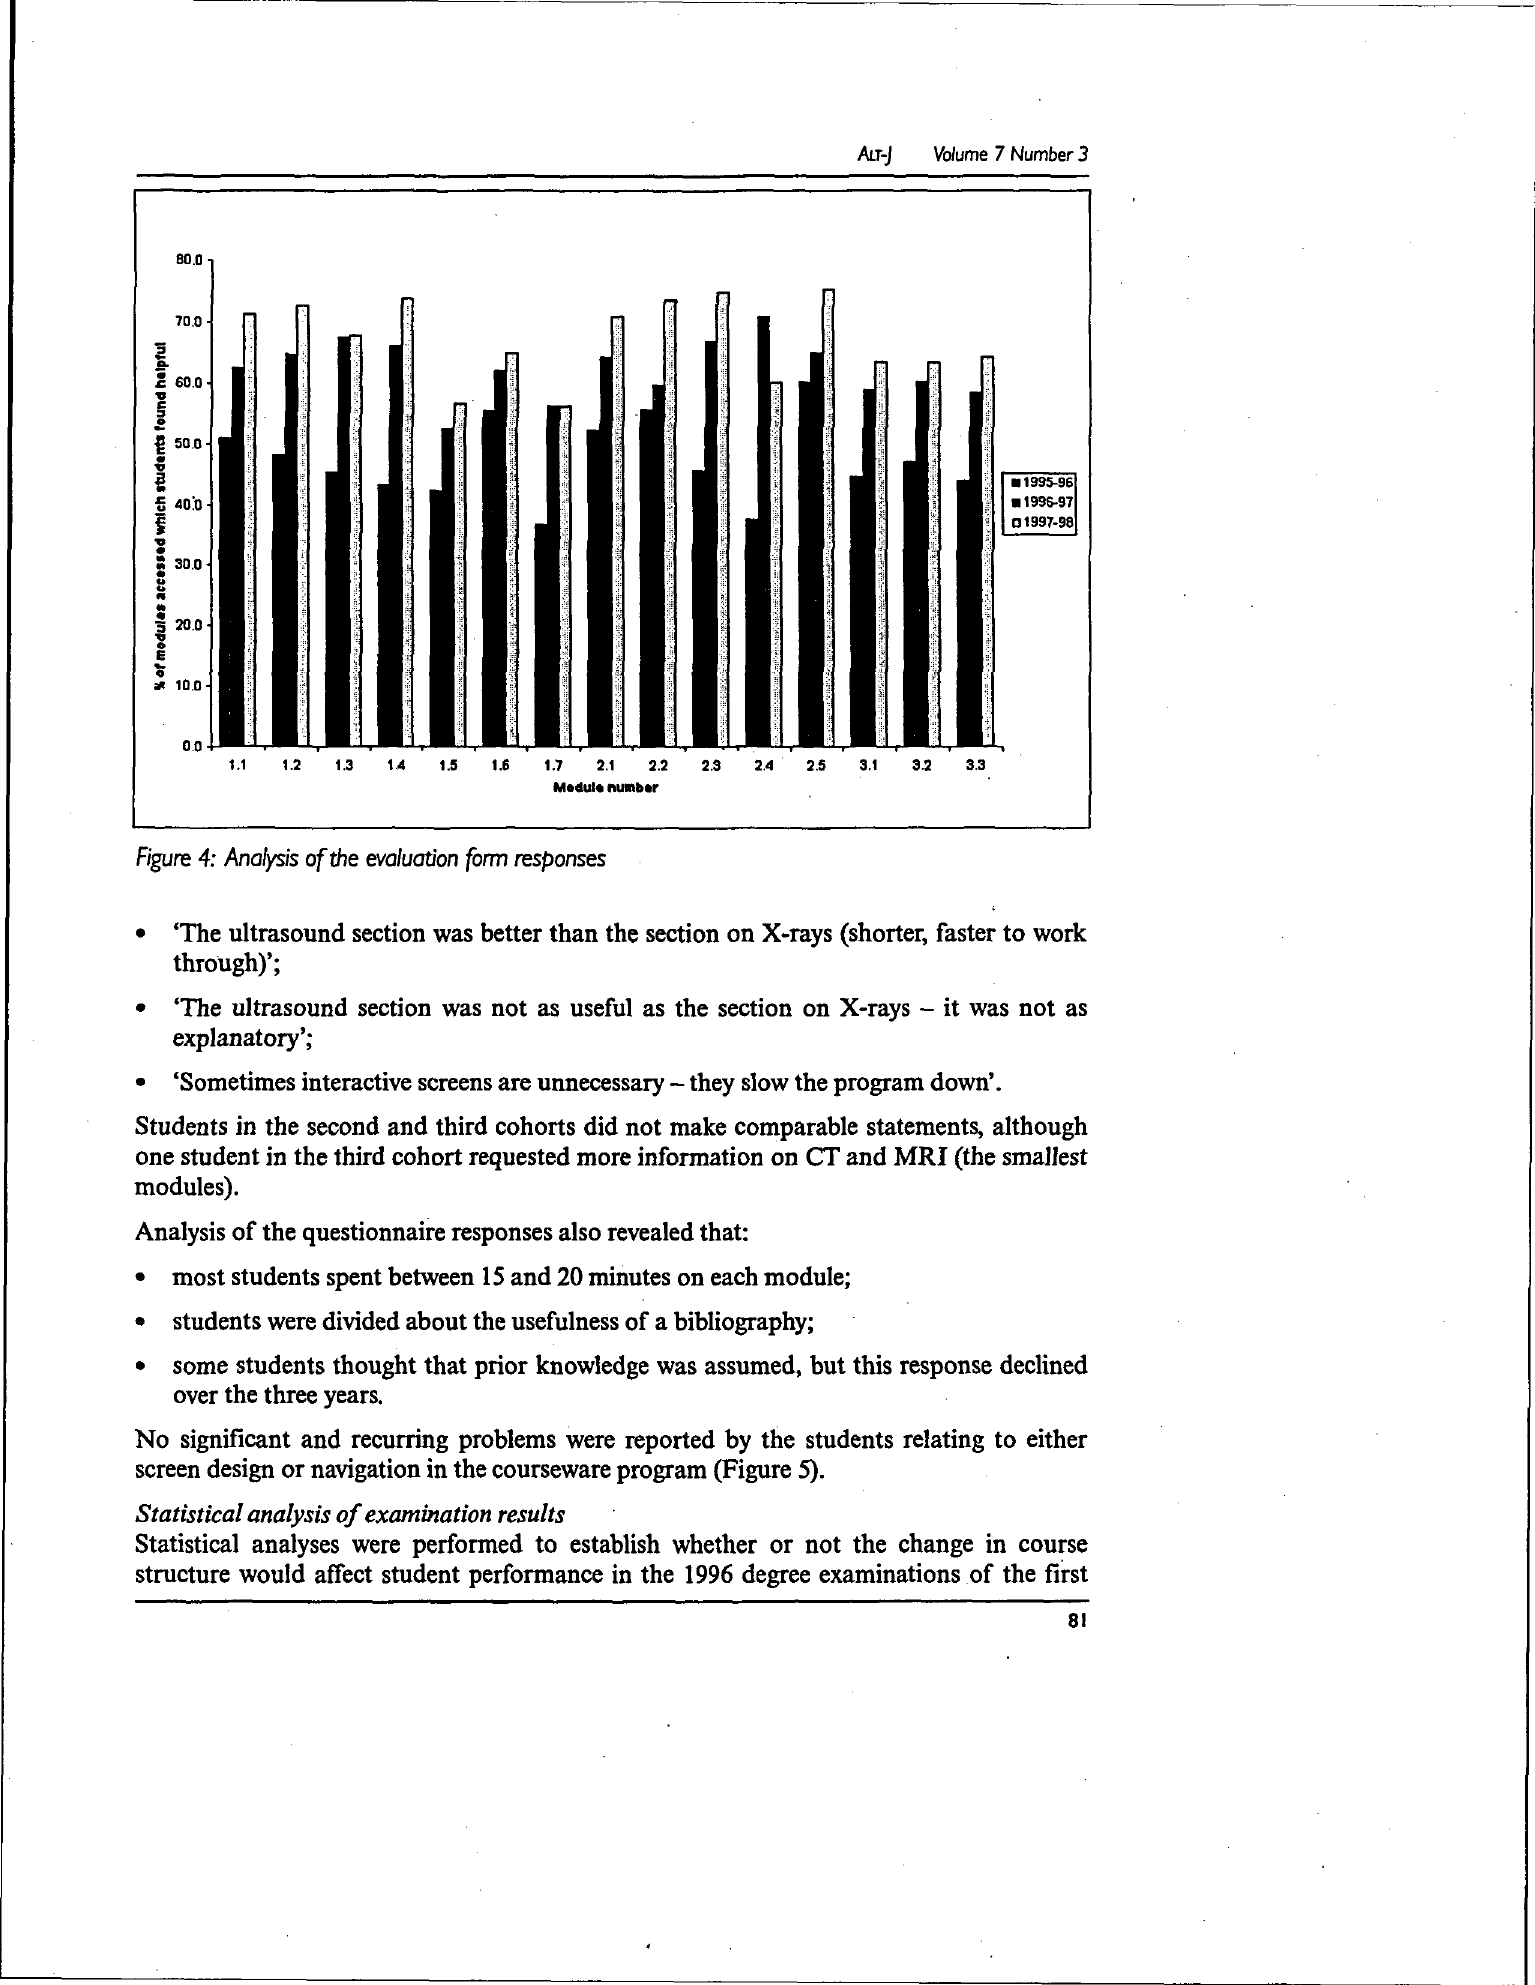
Figure 4: Analysis of the evaluation form